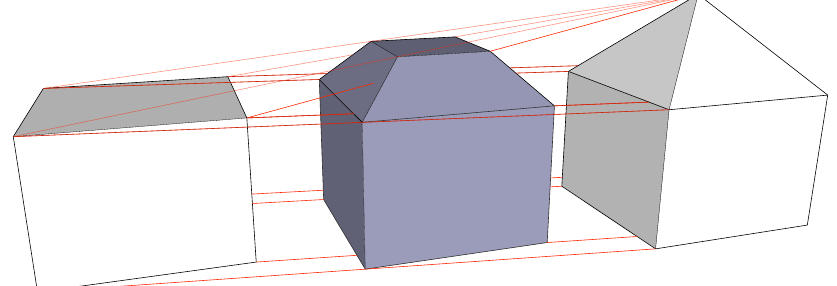
Figure 6. Two LODs of a 3D model of a house (left and right) are linked despite not being isomorphic, with an intermediate LOD that shows the result of slicing the construction at an intermediate LOD